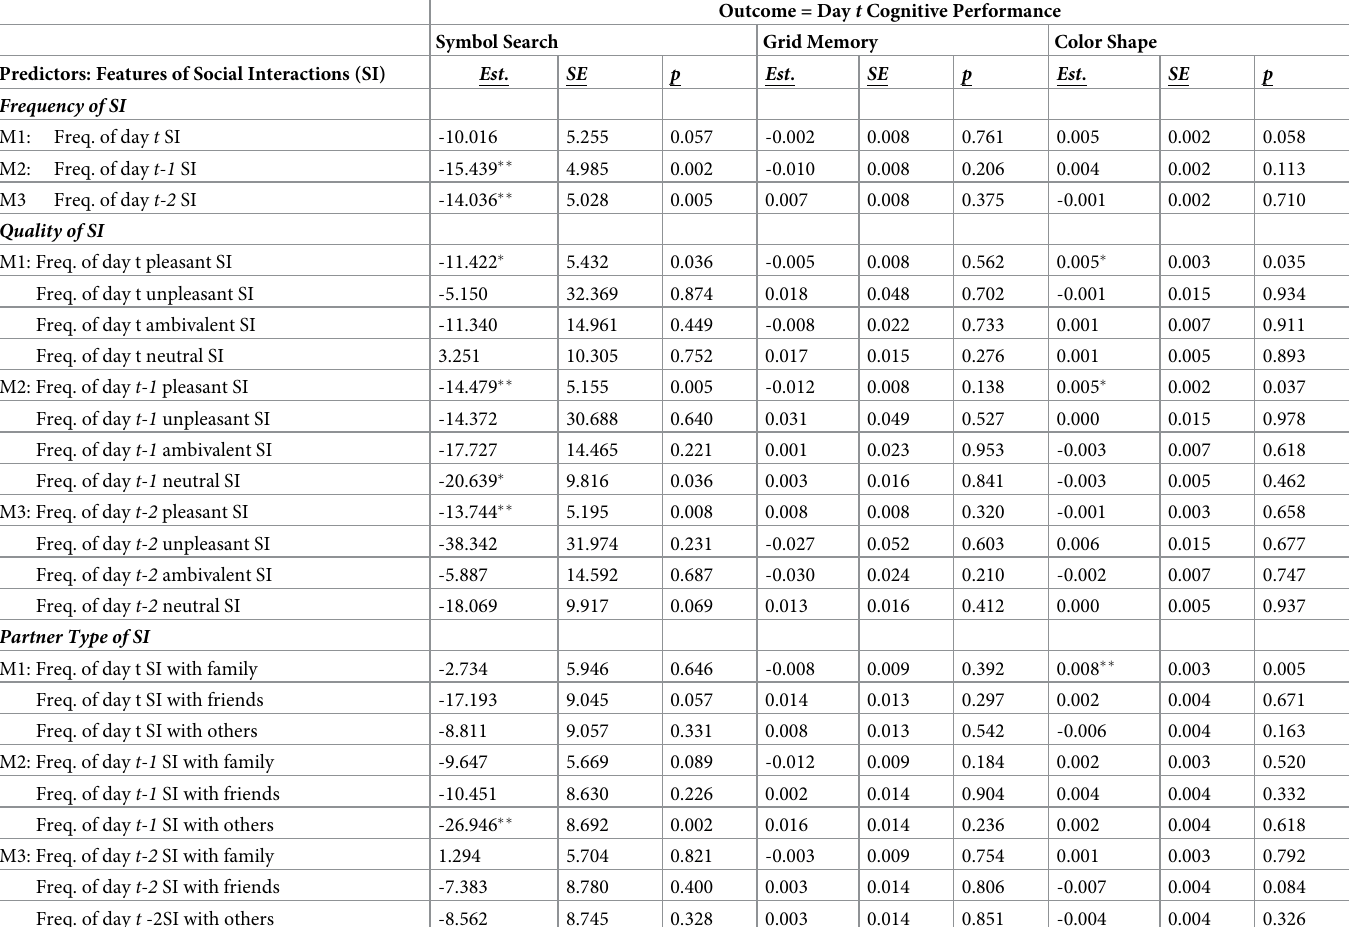
Table 2. Summary of the same-day and cross-day within-person effects of daily social interactions on daily cognitive